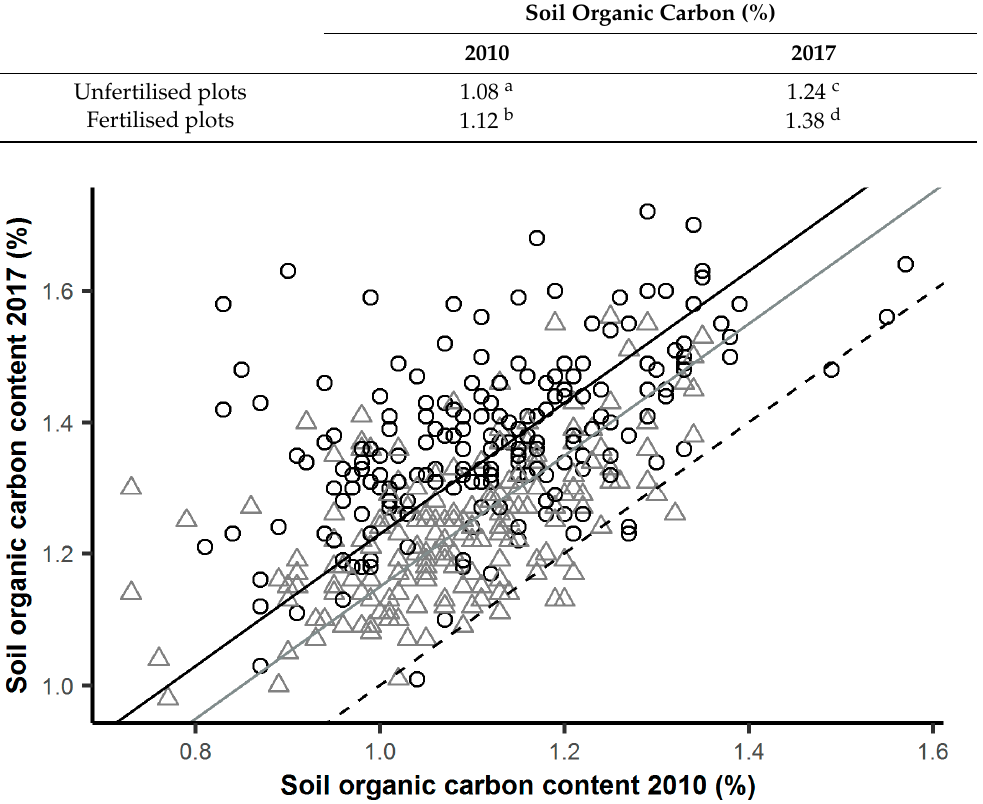
Table 5. Soil organic carbon content (%) in 2010 and 2017 (means sharing a letter are not significantly different, p < 0.001).